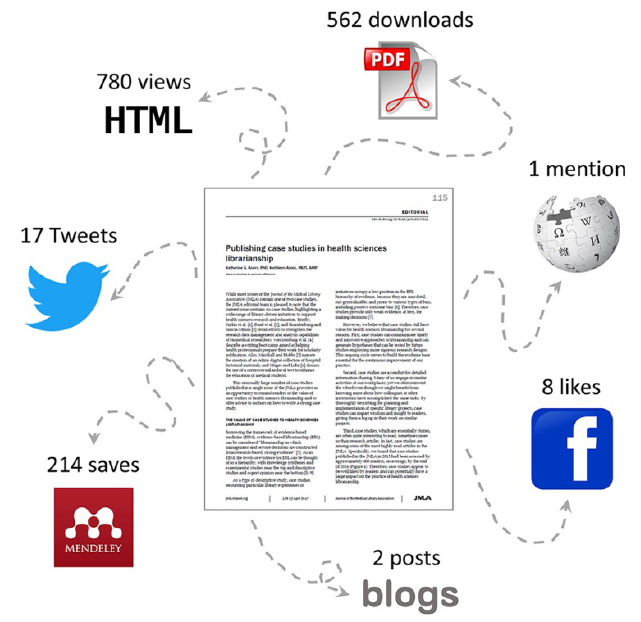
Figure 1 Depiction of altmetrics for a journal